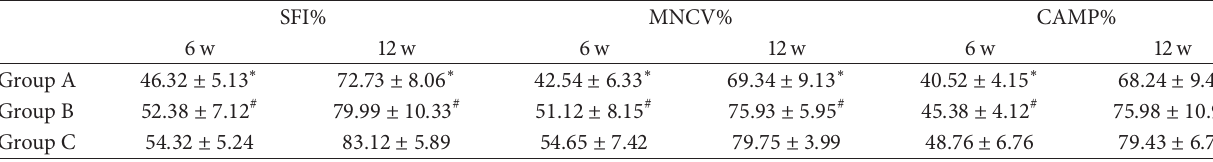
Table 1: Comparison of SFI%, MNCV%, and CAMP% in 3 groups ( 𝑥 ± 𝑠 , 𝑛 = 15 ).